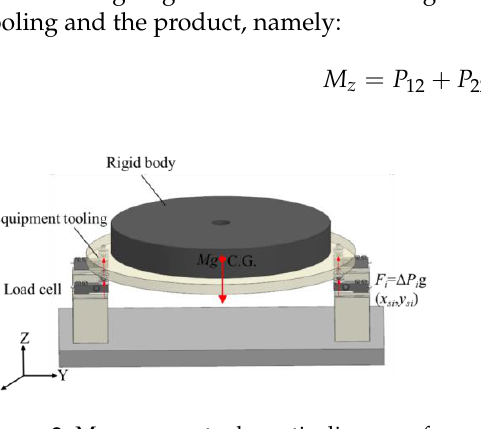
Figure 2. Measurement schematic diagram of mass centroid coordinates.